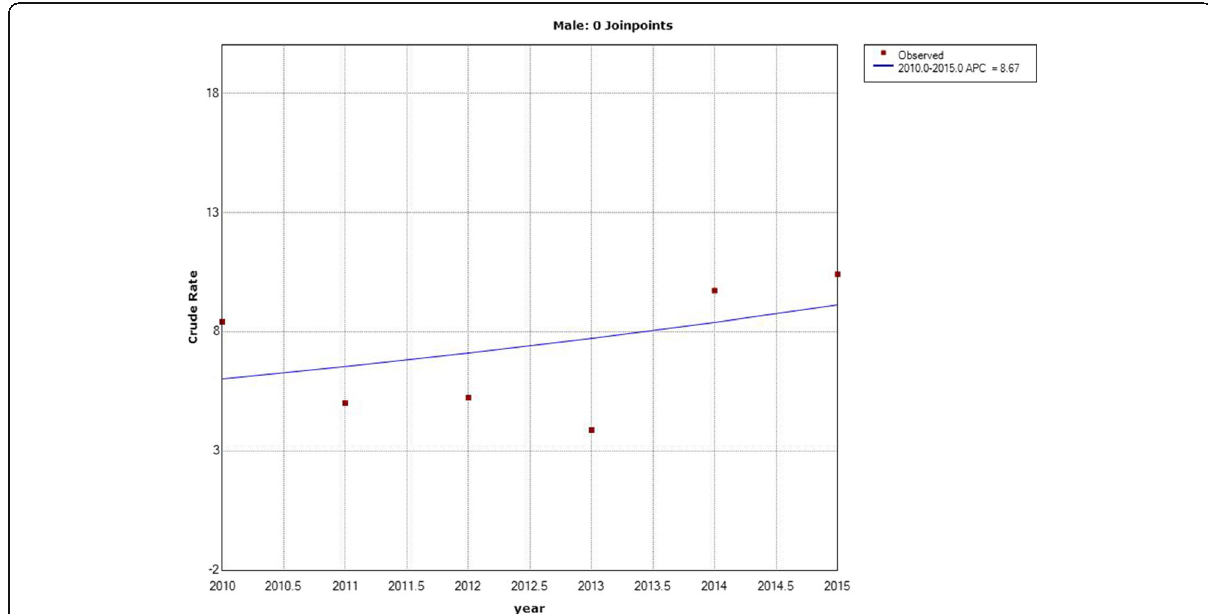
Fig. 2 Fitted segment lines of Male annual suicide rate per 100,000 population using Joinpoint regression models. ^Indicates that the Annual Percent Change (APC) is significantly different from zero at the alpha=0.05 level. Final Selected Model: 0